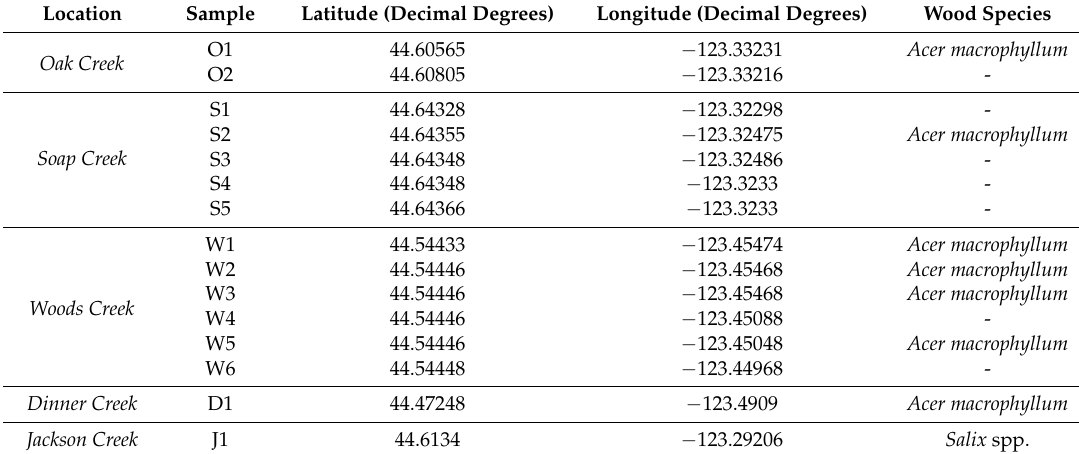
Table 1. GPS coordinates of fallen wood containing Chlorociboria spp. taken with Easy GPS in Mary’s Peak and McDonald-Dunn Forests.